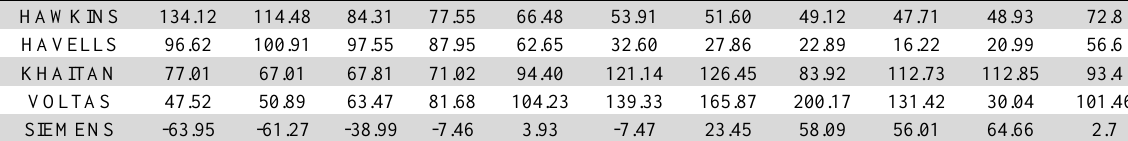
Analysis of Cash Conversion Cycle of Selected Companies of Consumer Durable Sectors (in Days) HAWKINS 134.12 HAVELLS 96.62 VOLTAS 47.52